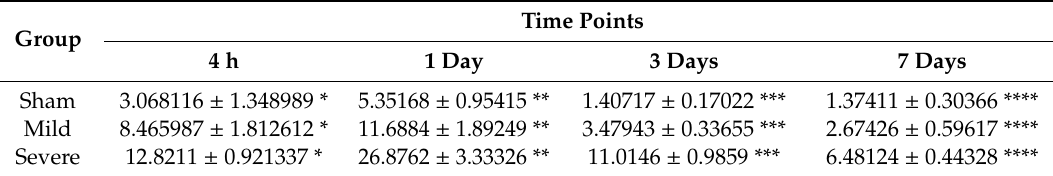
Data are mean ± SEM (SEM: standard error of the mean). There were significant alterations in the level of miR-223 expression at all time points studied through all the experimental groups ( p < 0.05). Asterisks indicate significant di ff erences between the same ones at p < Asterisks indicate significant differences between the same ones at P < 0.05.